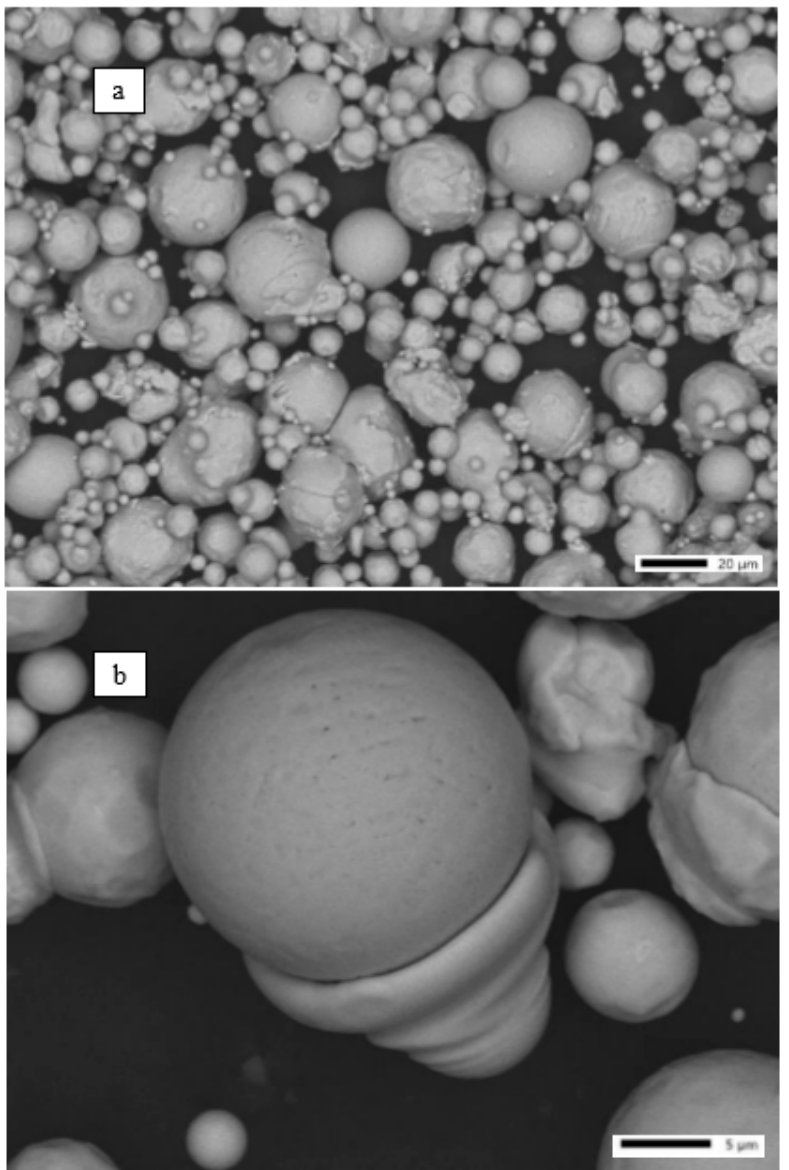
Figure 1. Prealloyed, atomized Inconel 718 powder SEM images. ( a ) Low magnification. ( b ) High magnification.